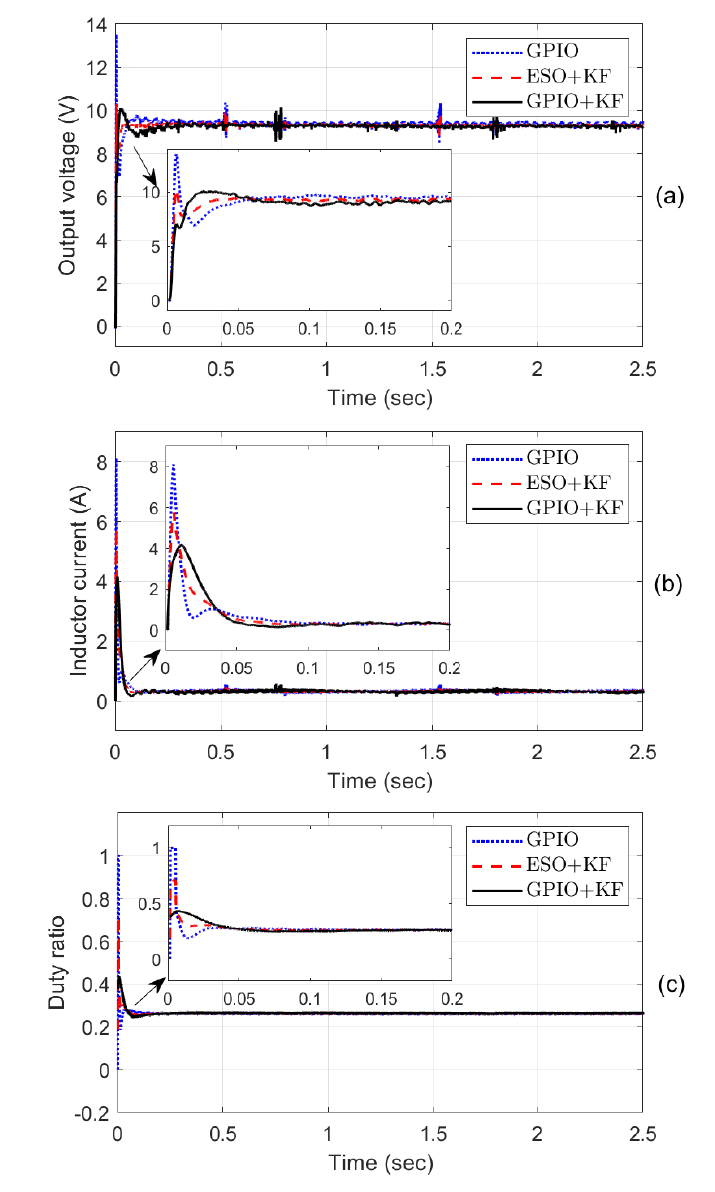
Figure 3. Waveform curves when the system is just started. ( a ) Output voltage. ( b ) Inductor current. ( c ) Duty